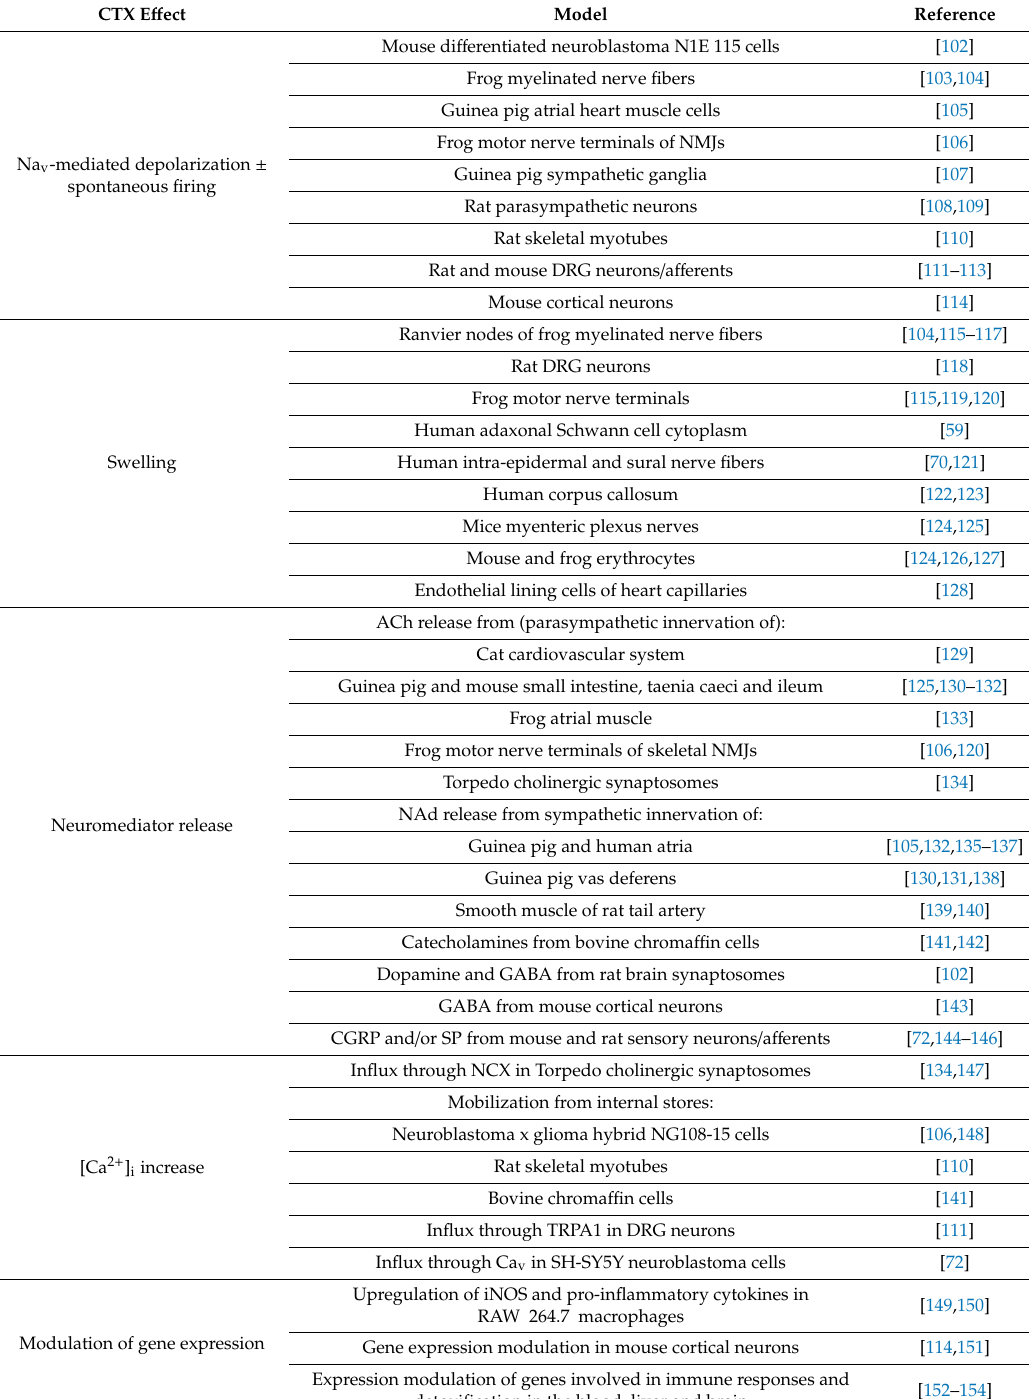
Table 1. Electrophysiological and neurocellular e ff ects of